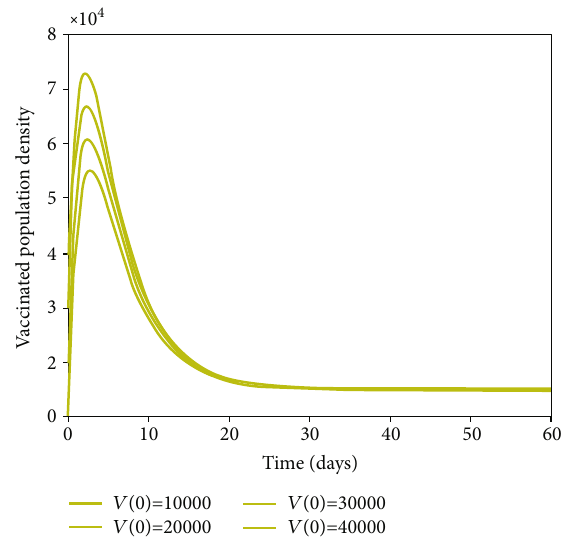
Figure 5: The time series plot of the vaccinated population.